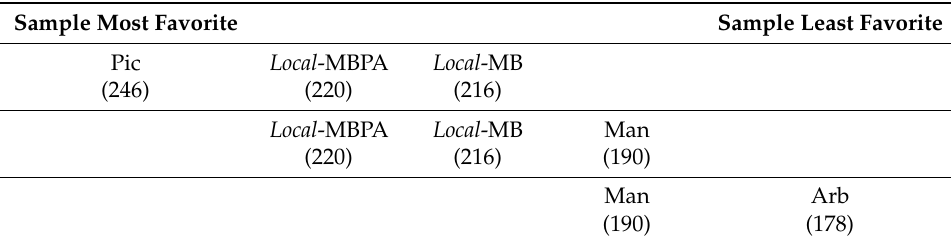
Table 3. Total preference values and LSD results obtained from the studied